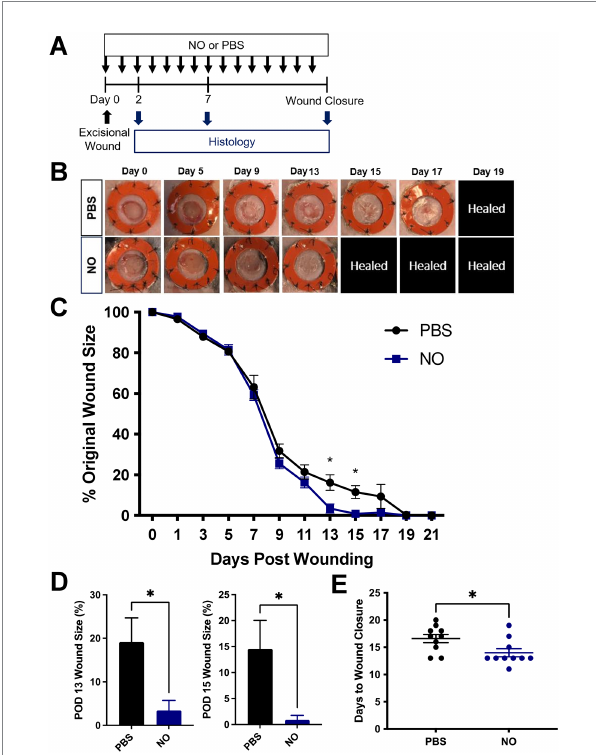
FIGURE 1 (A) Experimental overview of excisional wounding and treatment. (B) Representative images of the wound over time by treatment group, where NO = Nitric Oxide gel; PBS: Phosphate-Buffered Saline-gel control. Healed = healed wound that has closed. (C) Quantification of wound area over time by treatment group. (D) Wound area size at postoperative (POD) 13 and 15. (E) Days until complete wound closure by treatment group. Data are presented as mean value ± SEM, * p <